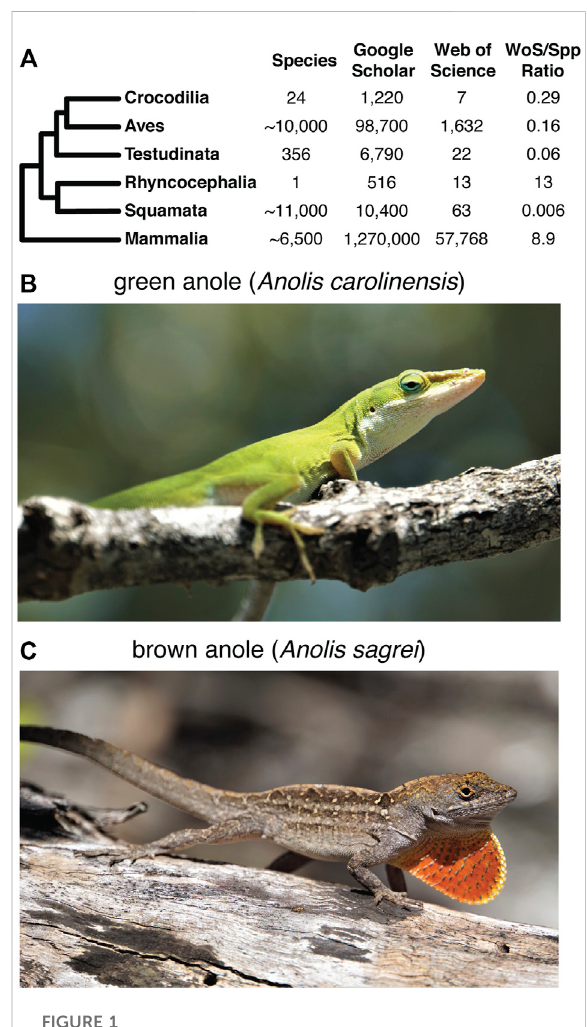
FIGURE 1 OverviewofpreviousresearchonthesquamateMHCandthe focal species for this study. (A) Summary of the approximate numberofspeciesineachmajoramniotecladeandthenumberof search results of literature searches of Google Scholar and Web of Science using keywords for MHC and the respective amniote clade. The ratio of the number of search result hits based ontheWebofSciencequerytotheapproximatenumberofknown species for each clade provides a conservative picture of the disparity in MHC research effort in each amniote lineage. See Supplementary Materials and Methods for more details of how the literature search was performed. The literature searches were performed on 10 March 2022. Photos of a (B) green anole ( Anolis carolinensis ) and (C) brown anole ( Anolis sagrei ). Photo credits: Nicholas